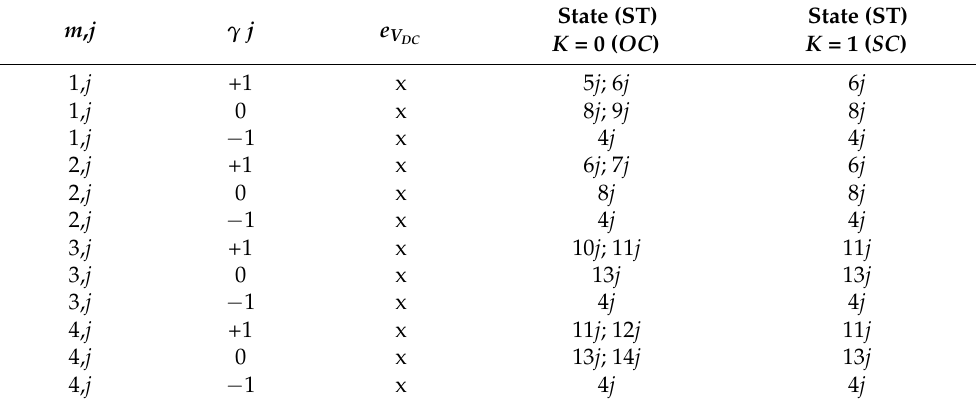
Table 3. Fault decision